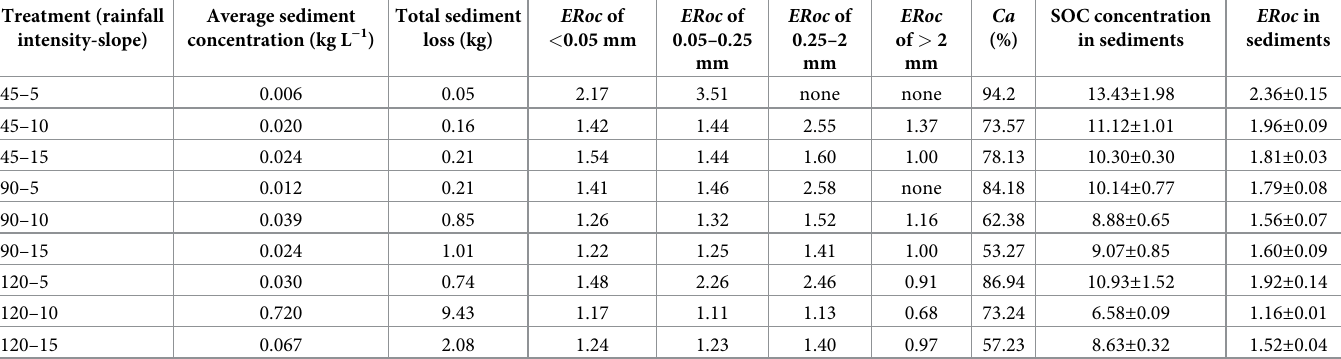
Table 3. Soil loss, SOC concentration in sediment particles, and OC enrichment ratios in the sediment particles ( ERocs ) for all treatments. Treatment (rainfall intensity-slope)